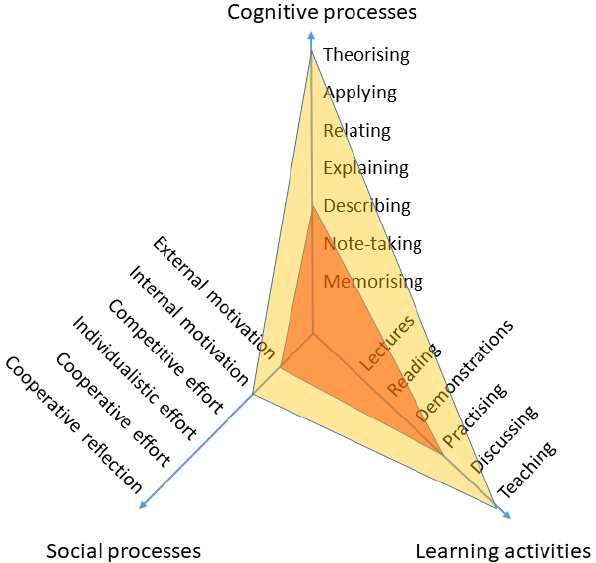
Figure 2: A surface approach to learning dominated by external motivating factors vs a deeper learn- ing approach dominated by internal motiva- tion